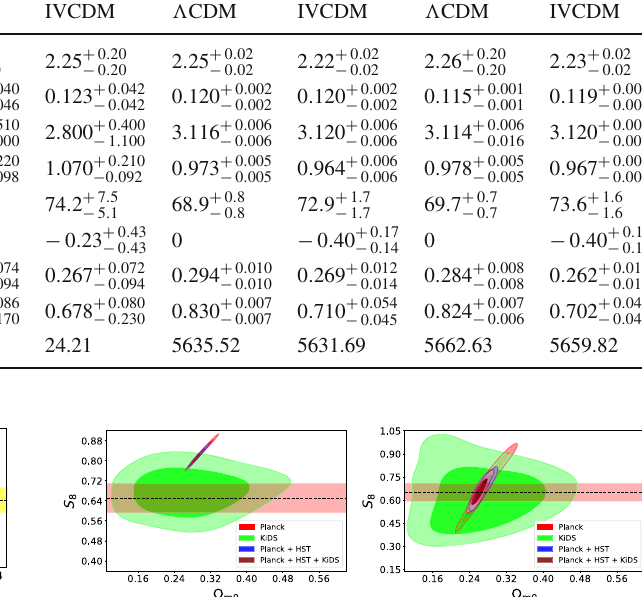
Table 1 Constraints (68% CL) on free and some derived parameters of the (cid:3) CDM and IVCDM models from the four data combinations. The final row displays χ 2 values of the statistical fit min Parameter